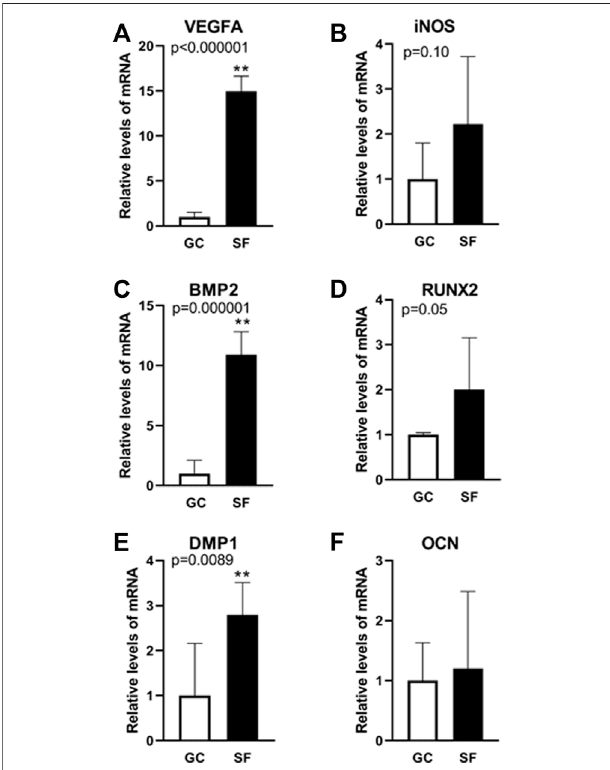
FIGURE 3 | Gene expression analysis related to angiogenesis and osteogenesis in mouse calvaria. Relative mRNA expression levels determined using qPCR analysis of angiogenesis-associated marker genes (VEGFA (A) , iNOS (B) ) and osteogenesis-associated marker genes (BMP2 (C) , RUNX2 (D) , DMP1 (E) , OCN (F) ) in GC and SF mice calvaria. Values are expressed asmean±SE.Signi fi cantdifferencesareindicatedby** p < 0.0001 from an unpaired Student ’ s t-test followed by Mann-Whitney u-test (n = 6 GC and 6 SF animals).